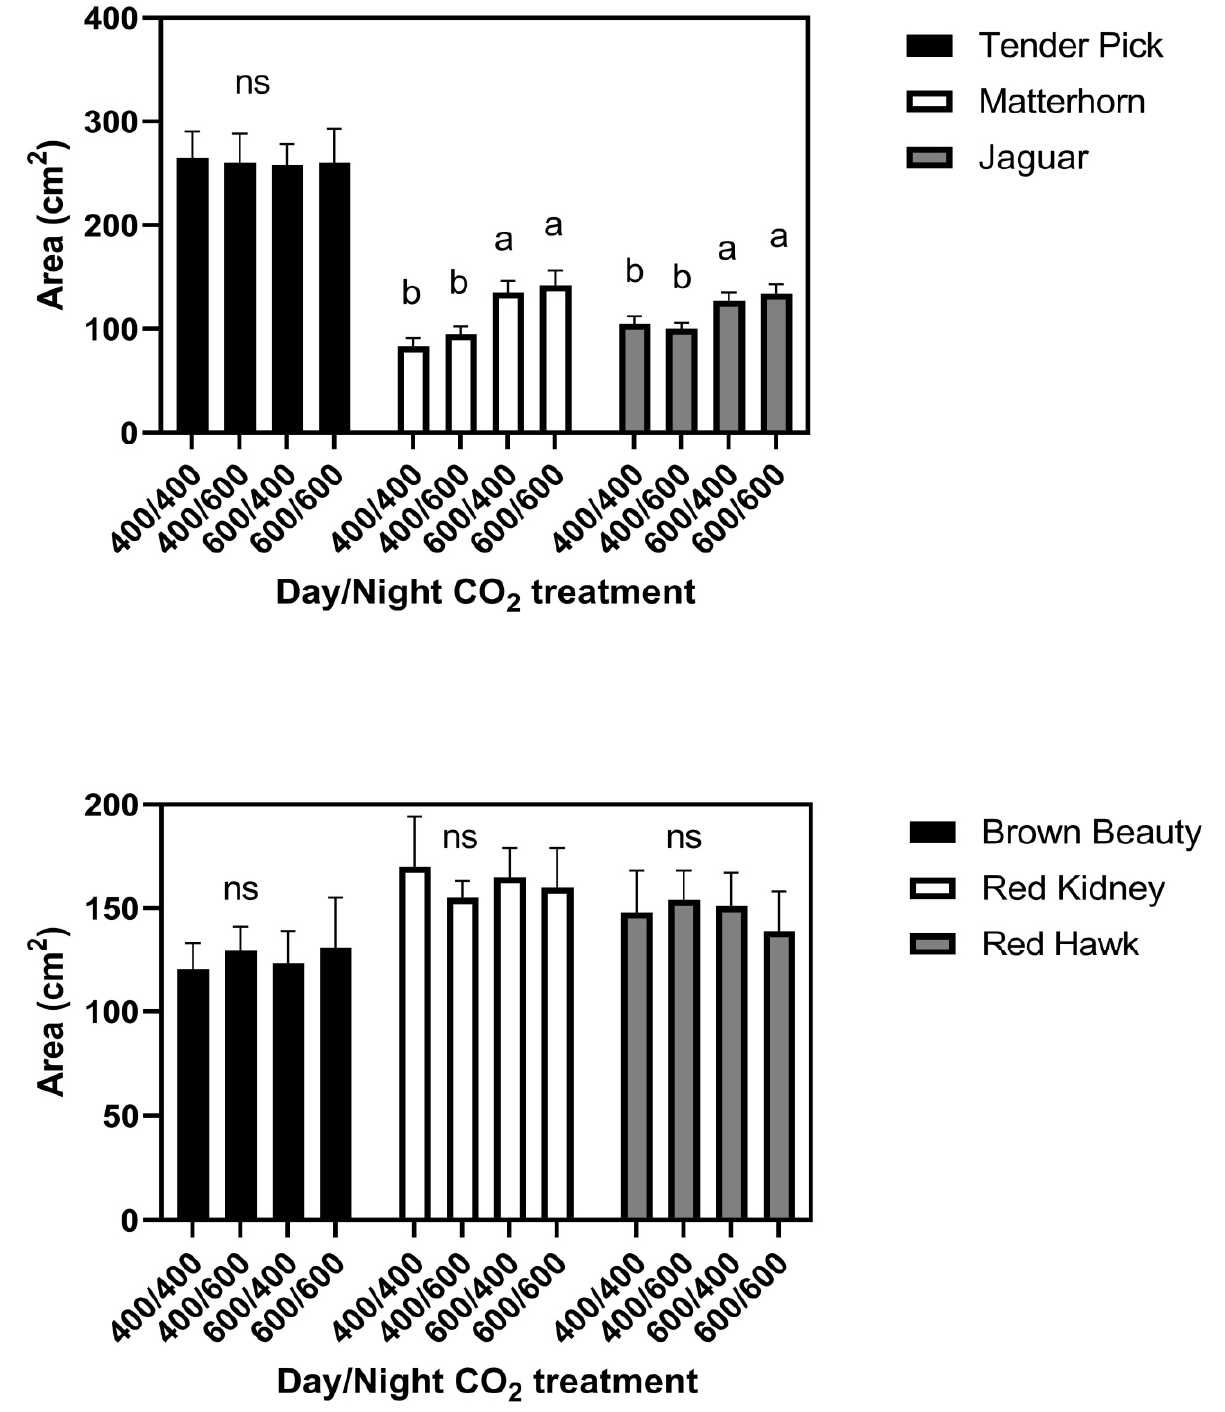
Figure 1. Area of terminal leaflets of third mainstem trifoliolate leaves of six cultivars of common bean grown with four day/night CO 2 concentrations ( µ mol mol − 1 ) at constant 23 ◦ C. Bars indicate standard deviations, and different letters within cultivars indicate differences among CO 2 treatments, using ANOVA at p = 0.05, and ns indicates no significant differences among CO 2 treatments.